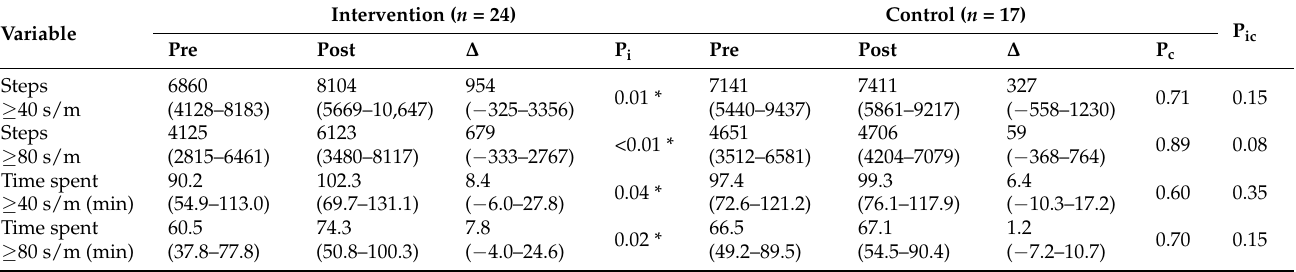
Table 3. Quality of ambulatory behavior: purposeful stepping and medium-intensity